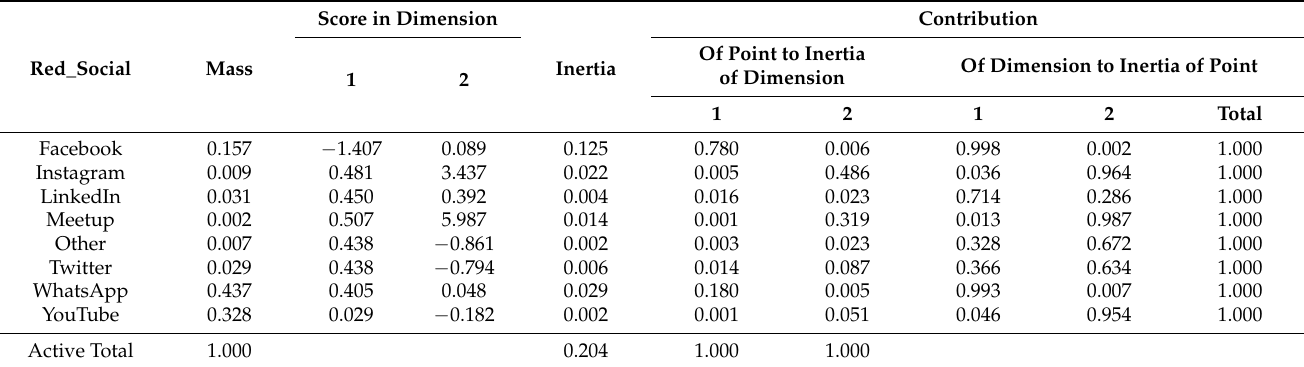
Table A6. Overview of correspondence score by column. Positioning and traffic obtained from social